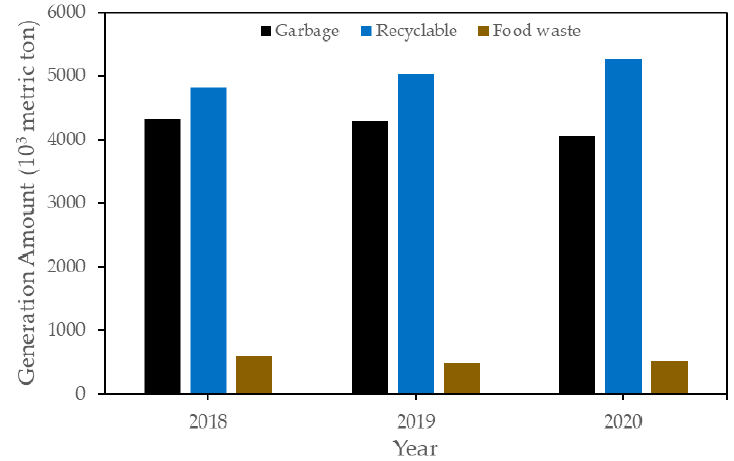
Figure 2. Variations in the generated amounts of MSW and their type in Taiwan since 2018 [18]. Table 3. Reported amounts of plastic containers and other plastic products recycled by imple- menting agencies in Taiwan since 2016 1 .